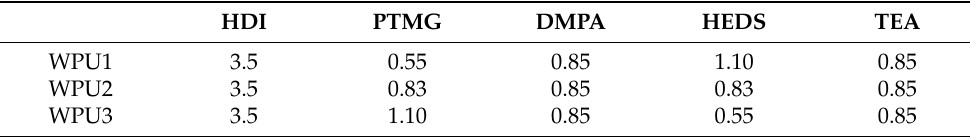
Table 1. Molar ratio formulations of different WPU